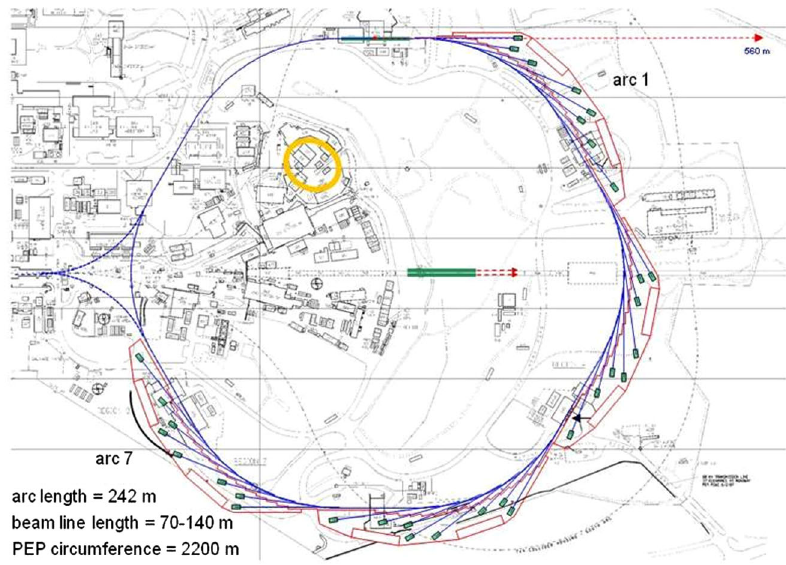
FIG. 1. Layout of PEP-X at SLAC as an ultimate storage